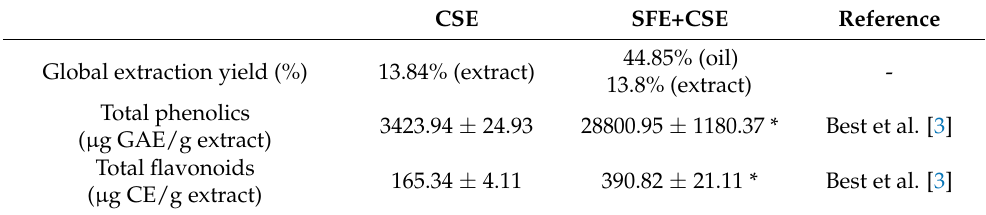
Table 5. Global extraction yields, total phenolics, and total flavonoids in the extracts obtained by the single-stage process by conventional solvent extraction (CSE) and the sequential two-stage process using supercritical and conventional solvent extraction